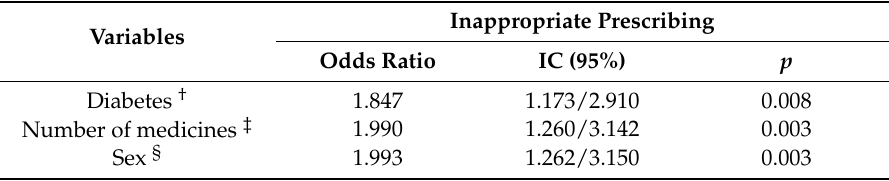
Table 3. Variables associated with Inappropriate Prescribing (logistic